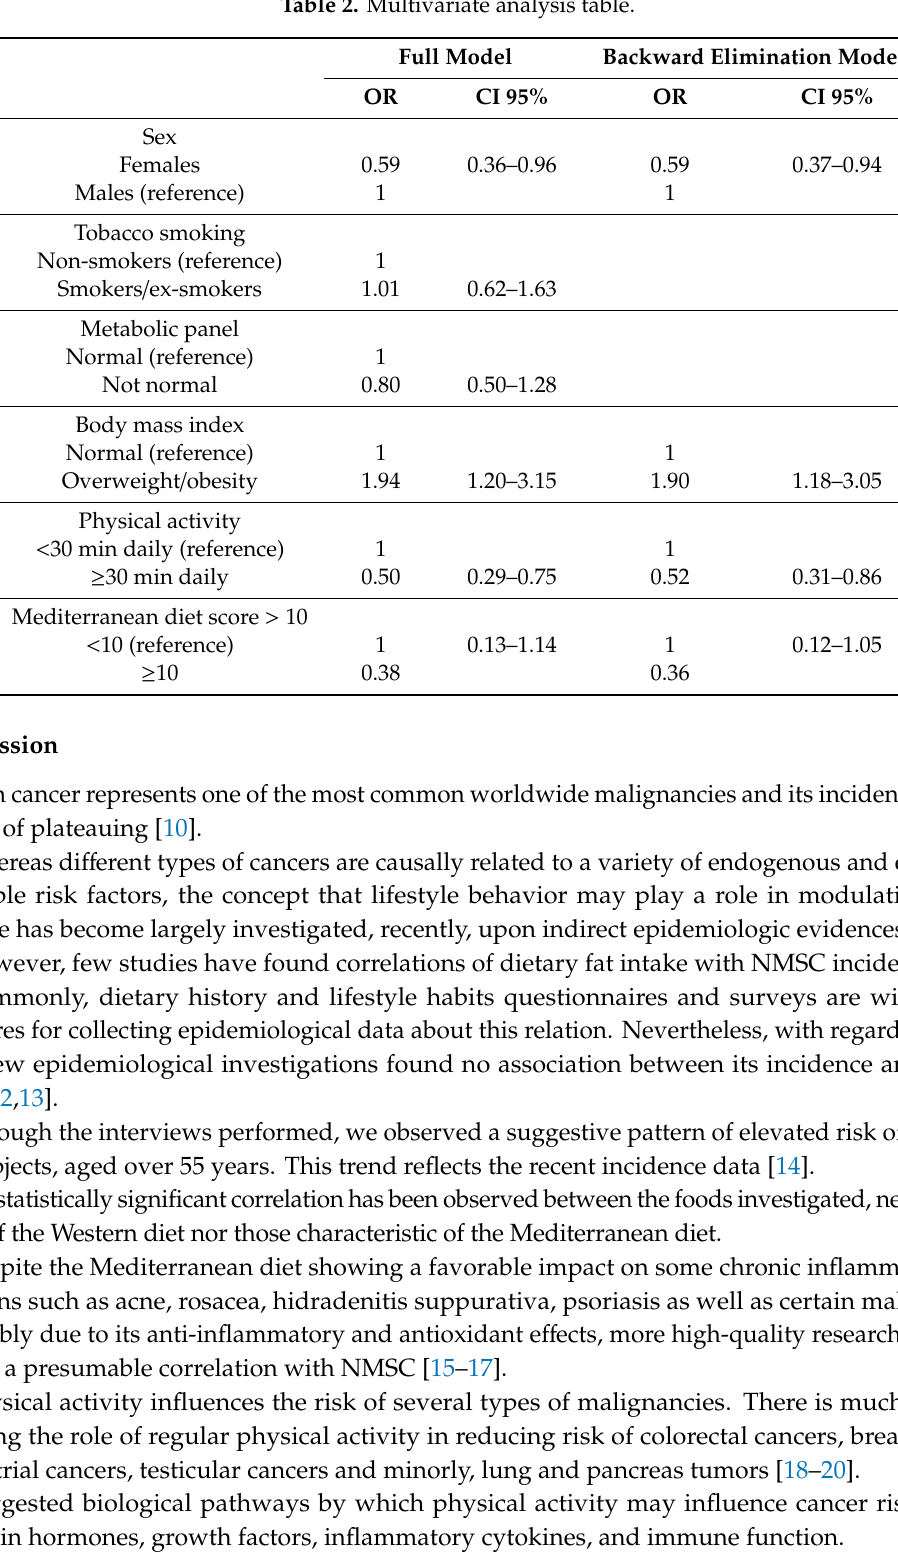
Table 2. Multivariate analysis